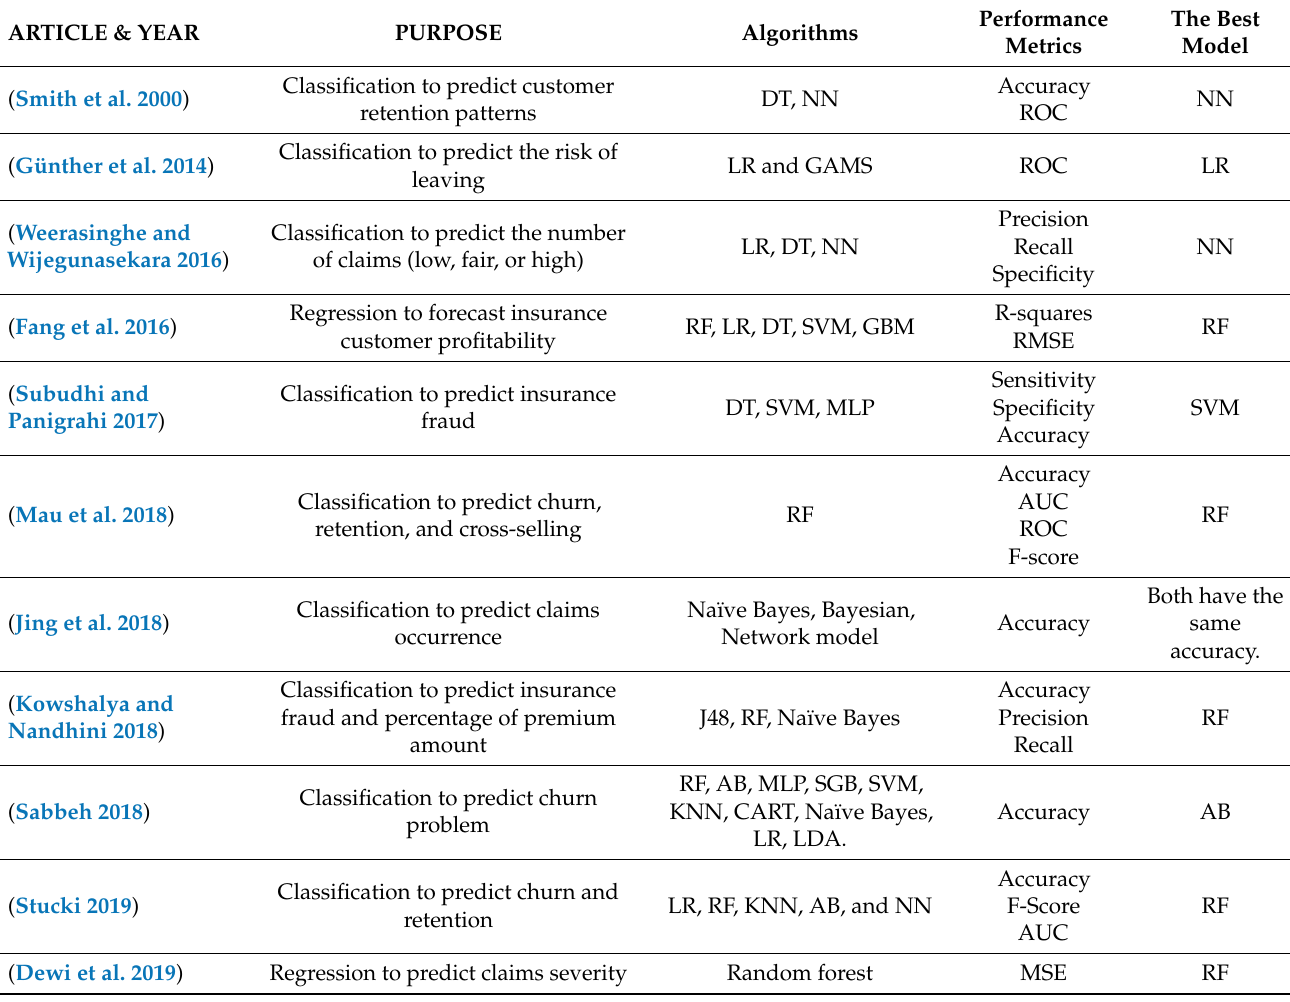
Table 1. Different studies for using ML models in the insurance industry to get a representative